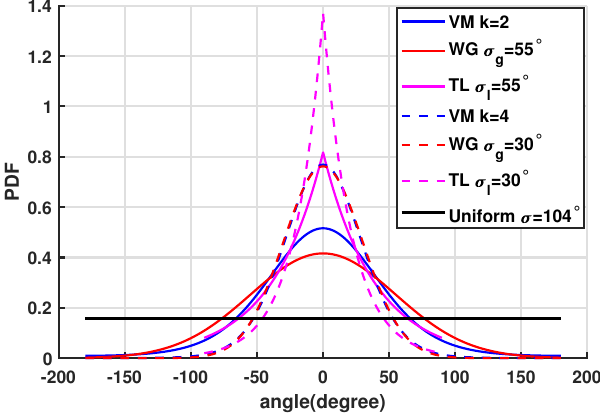
Figure 2. PDFs of different angle